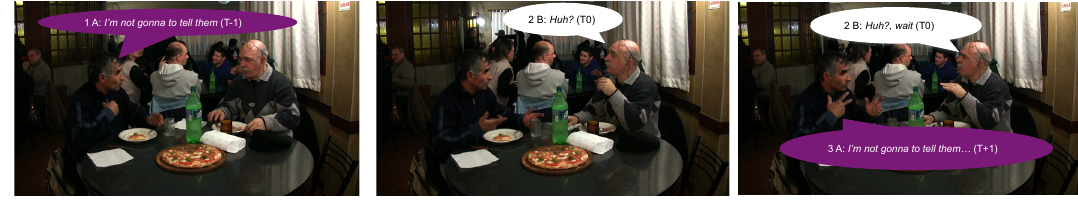
Figure 4. ‘Huh?, Person B (right) initiates repair on Person A’s prior turn using three consecutive formats (line 2). First, B raises his eyebrows; second he brings his eyebrows together; and third, he raises his left hand ‘Wait’ (see Figure 5).